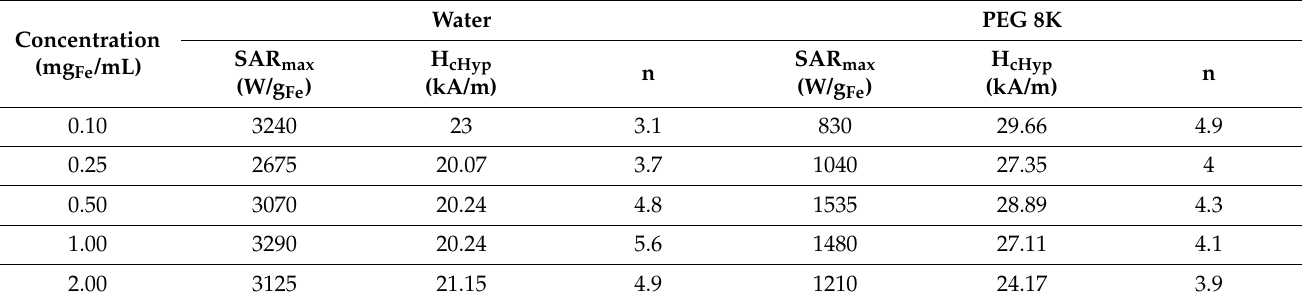
Table 2. SAR max , H cHyp, and n for the samples measured in water and PEG 8K.